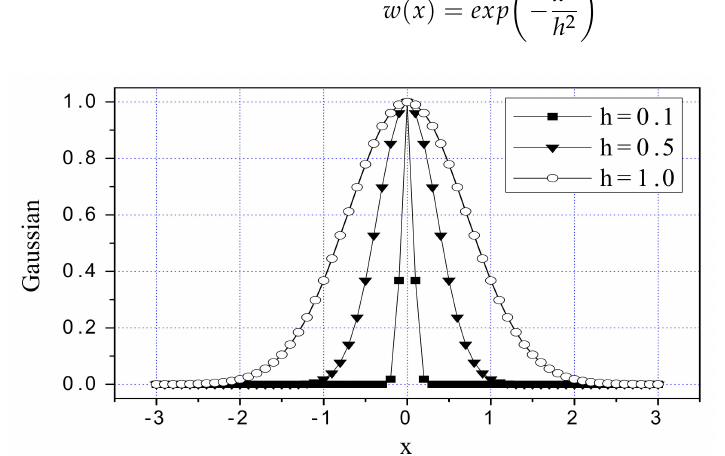
Figure 11. Gaussian weighting